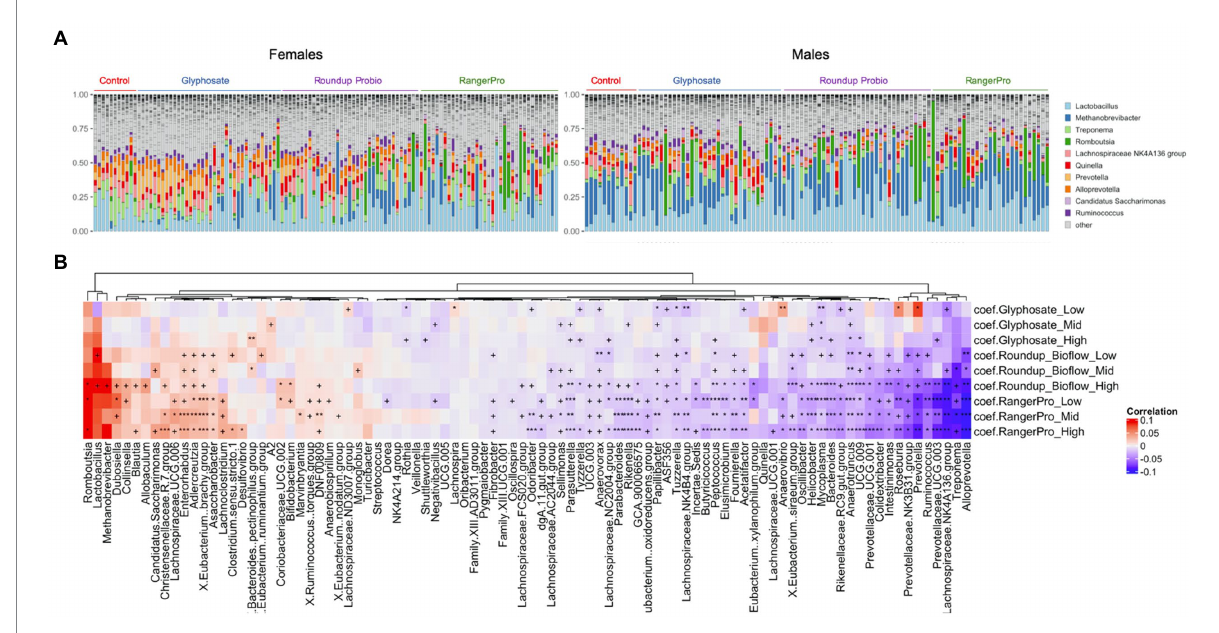
FIGURE 3 Glyphosate and its herbicide formulations Roundup Bioflow and RangerPro cause large scale alterations in gut microbiome taxonomic composition. Male and female Sprague–Dawley rats were exposed to glyphosate or the herbicide formulations at 0.5, 5 and 50 mg/kg bw/day glyphosate starting at mid-gestation and ending at 13 weeks post-weaning. (A) . Visualisation of the top 10 genera across all the samples from the caecum microbiome dataset. (B) . Heat map of statistically significant differences in abundance caused by exposure to the test substances. The colour scale is the effect size from a multivariate association analysis showing if a bacterial genera is more abundant (red) or less abundant (blue) than in the control group. The statistical significance is the FDR indicated by symbols (***FDR < 0.001; **FDR < 0.01; *FDR < 0.05; FDR <